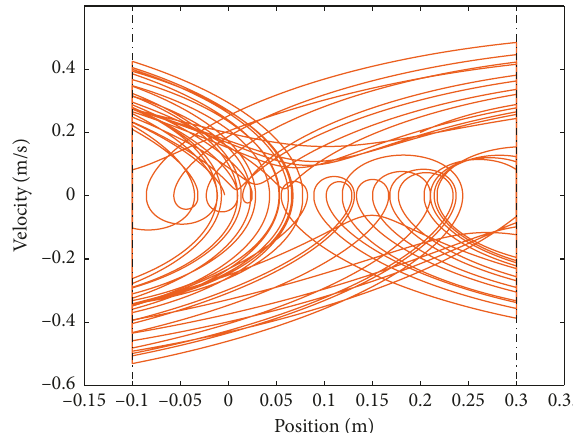
Figure 3: Phase portrait of the double-sided 1-DoF impacting mechanical oscillator for the parameter w � 0 . 8 showing a chaotic attractor.